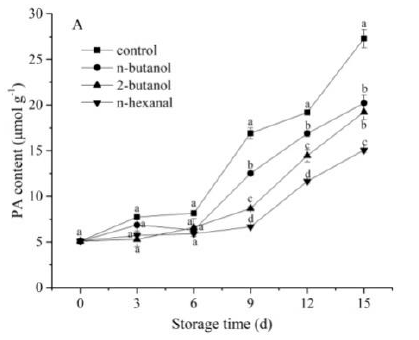
Figure 3. Effect of phospholipase D inhibitors treatment on PLD ( A ) and LOX activity ( B ) of postharvest banana fruit in response to mechanical wounding stress. The vertical bars in each mean indicate the standard error ( n = 3). Different letters among treatments at the same time point indicate significant differences ( p < 0.05).